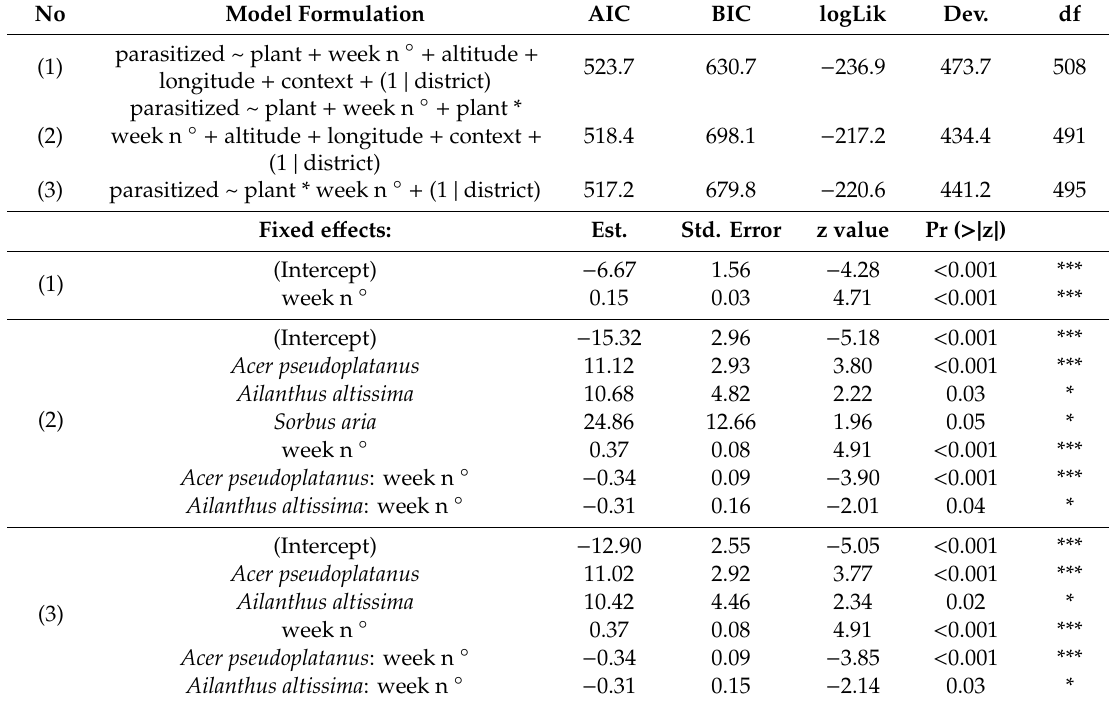
Table 2. Results of the generalized linear mixed-e ff ect models (GLMM) for egg parasitization for Halyomorpha halys egg masses, with the logit link function: a) formulation of the best three models; b) significant fixed e ff ects of the best three models. Dev (deviance), Est (estimate), df (df